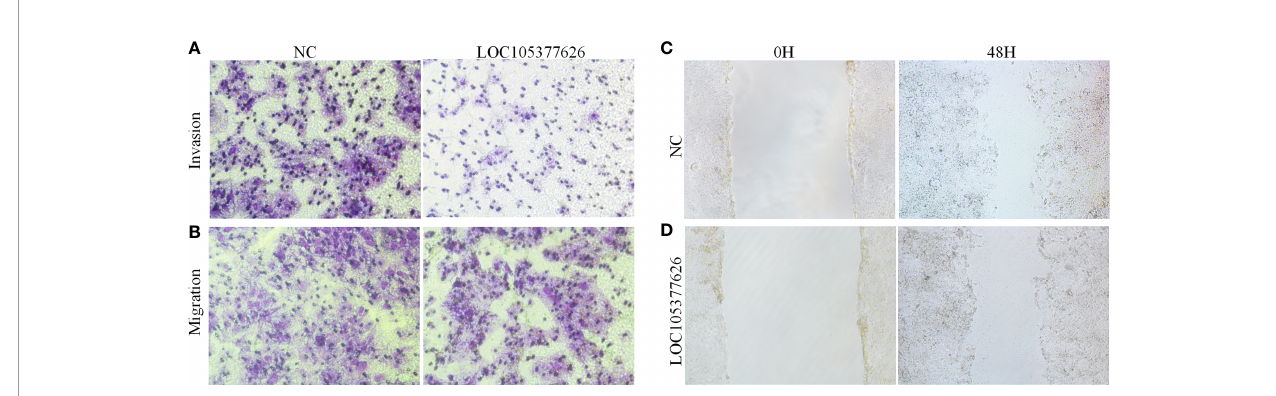
FIGURE 10 | Transwell and scratch assays results of LOC105377626 knockdown. (A, B) Results of Transwell (with and without Matrigel) assays between LOC105377626 control and knockdown groups, respectively, (C, D) Results of scratch assay between LOC105377626 control and